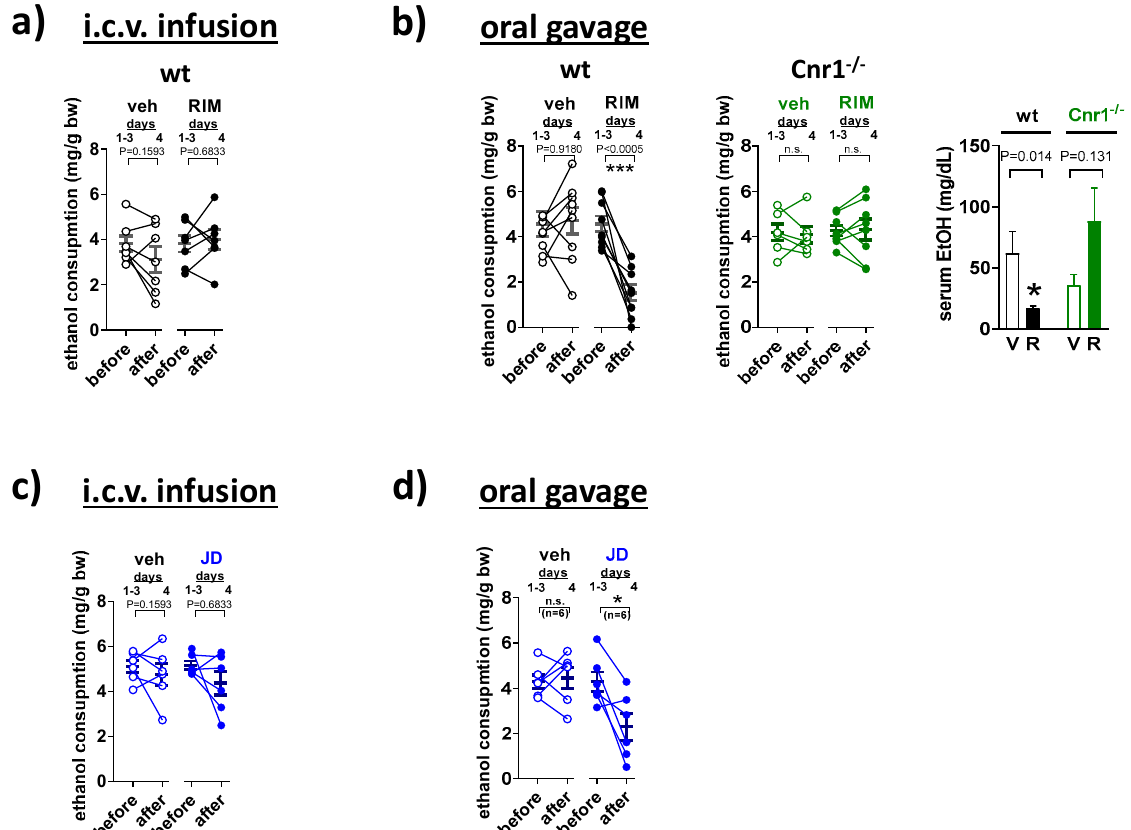
Figure 3. Relative involvement of central vs. peripheral CB1R blockade in the inhibition of voluntary ethanol intake by CB1 antagonists. Mice had access to 20% ethanol for 4 h each day. On day 4, one hour before the dark period, mice were infused intracerebroventricularly (i.c.v.) with ( a ) rimonabant (2 µ g, RIM, R), ( b ) JD5037 (1 µ g, JD) or their solvents (veh, V) and drinking session was repeated one more time. Another cohort of wild-type mice (wt) and/or their CB1 receptor-deficient (Cnr − / − ) counterparts received ( c ) rimonabant (10 mg/kg), ( d ) JD5037 (3 mg/kg), or vehicle by oral gavage. Drinking behavior in individual animals is expressed as points before (average of days 1–3) and after treatment (day 4). The corresponding serum ethanol values are shown as mean ± s.e.m. * p < 0.05; *** p < 0.001, compared with before treatment (Student’s t -test for paired samples), # p < 0.05 compared with the vehicle (Student’s t -test for unpaired samples), n.s. not significant.